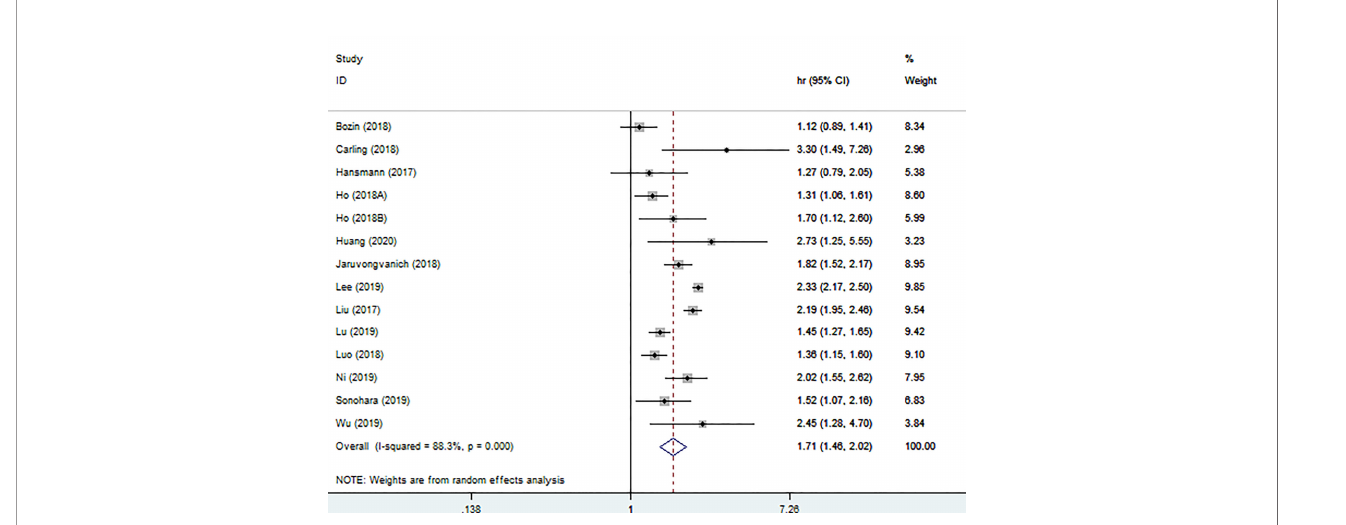
FIGURE 2 | Forest plot of the association between high PALBI grade and